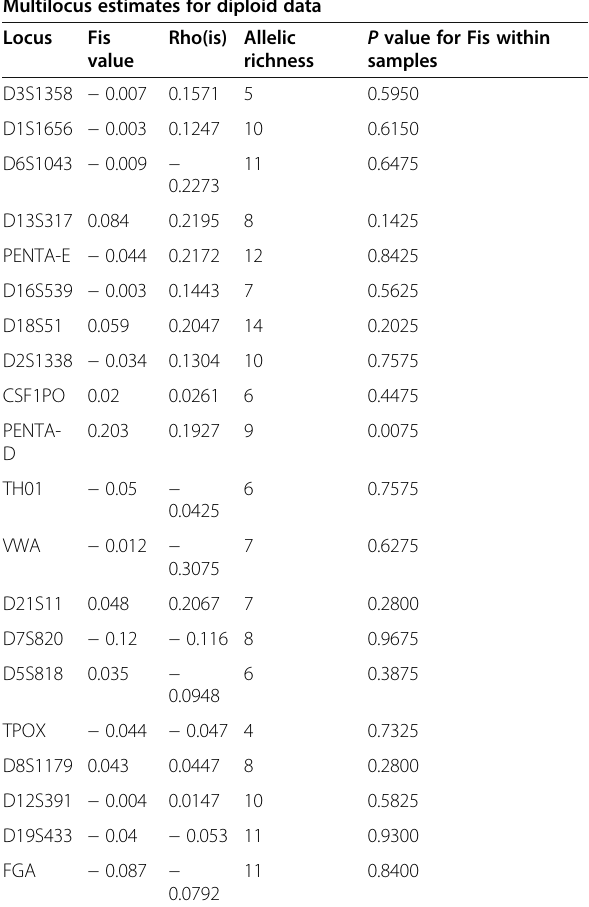
Table 5 FSTAT output reporting FIS Value, Rho (is), and allelic richness Multilocus estimates for diploid